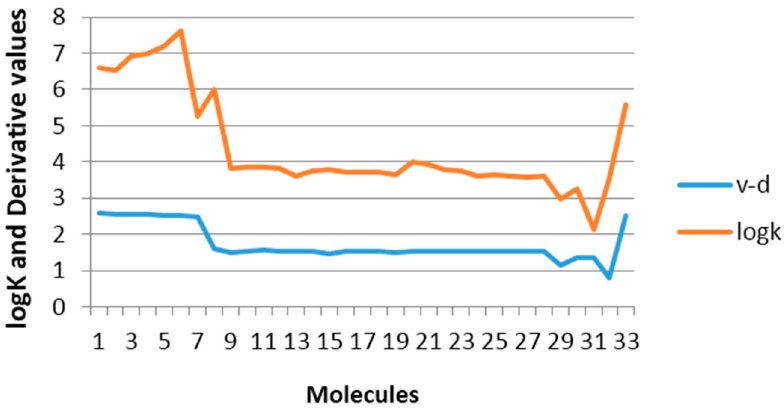
Figure 5. Regularity in the Derivative (over exocyclic double bond) variation and the log K values.